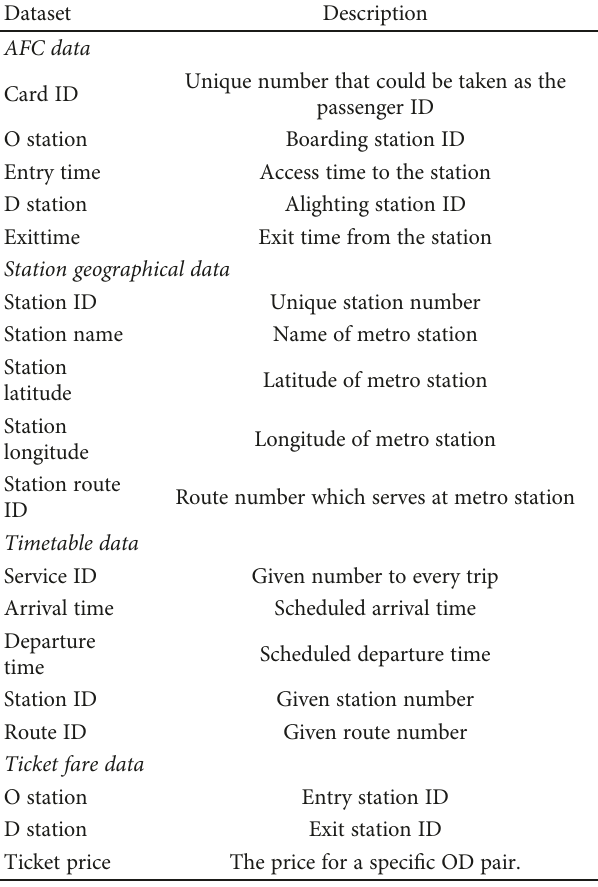
Table 2: Description of each dataset.